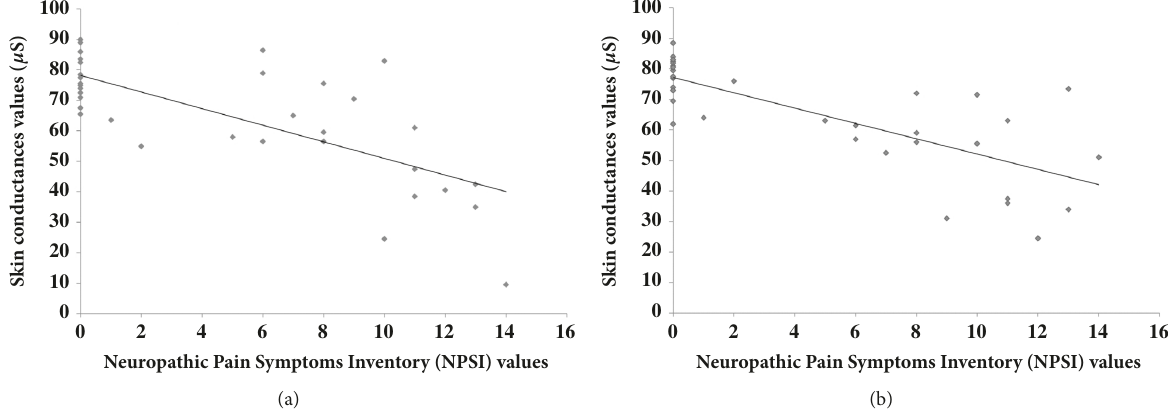
Figure 3: Correlation graphs between Electrochemical Conductance (ESC) in 𝜇 Siemens ( 𝜇 S) of hands (a) and feet (b) of treated patients and Neuropathic Pain Symptom Inventory (NPSI) scores (n = 36). ESC are correlated with NPSI score for hands (rho = -0.69, p < 0.0001) and feet (rho value = -0.79, p < 0.0001).